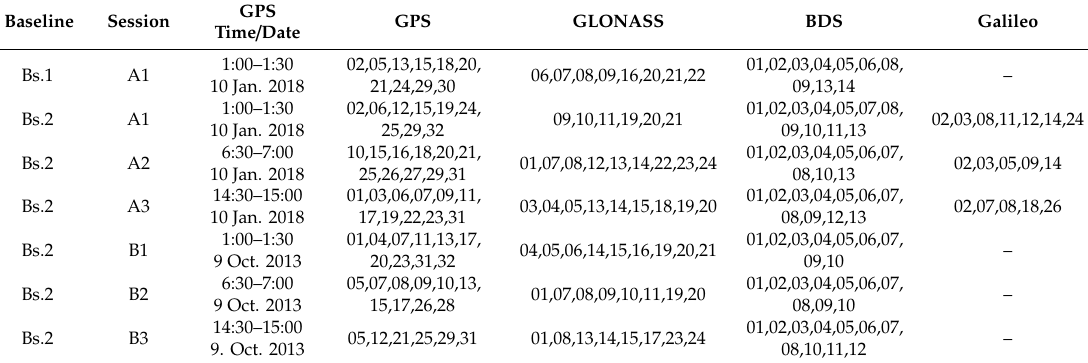
Table 4. Visible satellites during Session A1 for Bs.1 and Session A1-3, B1-3 for Bs.2.